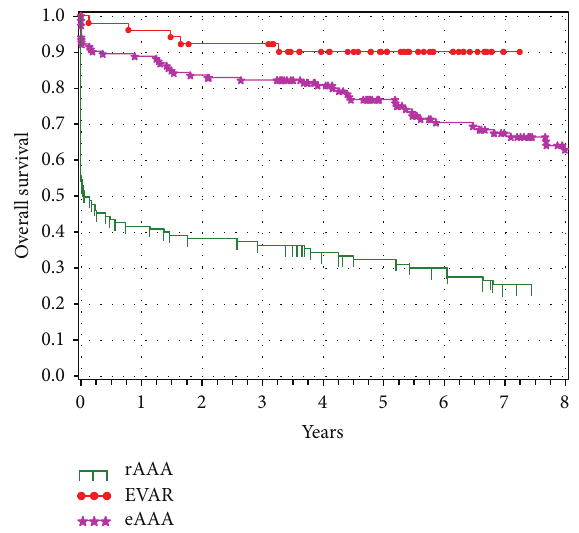
Figure 1: Survival analysis for patients after a ruptured abdominal aortic aneurysm (rAAA), elective open repair (eAAA), or elective endovascular repair (EVAR). Kaplan-Meier curves were generated with the indicated numbers of patients at risk. Reproduced with permission from